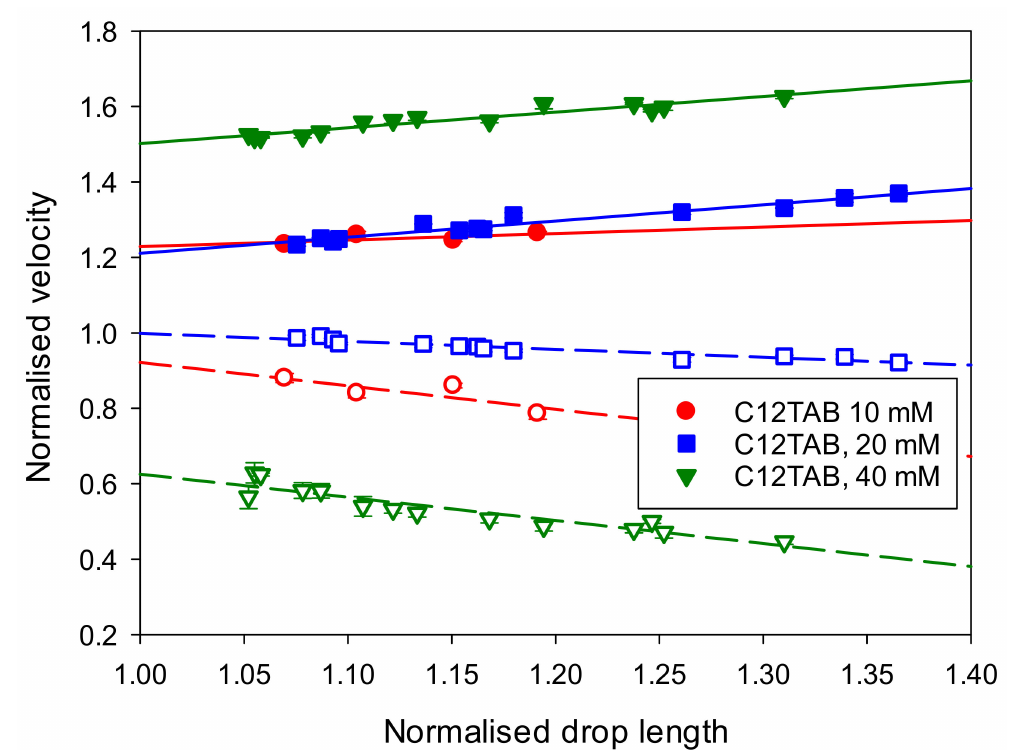
Figure 8. Dependence on the minimum and maximum velocity in the middle drop cross-section, normalized by the drop velocity on the drop length, normalized by the channel width for various concentrations of C 12 TAB. Filled symbols are for maximum velocity and empty symbols are for minimum